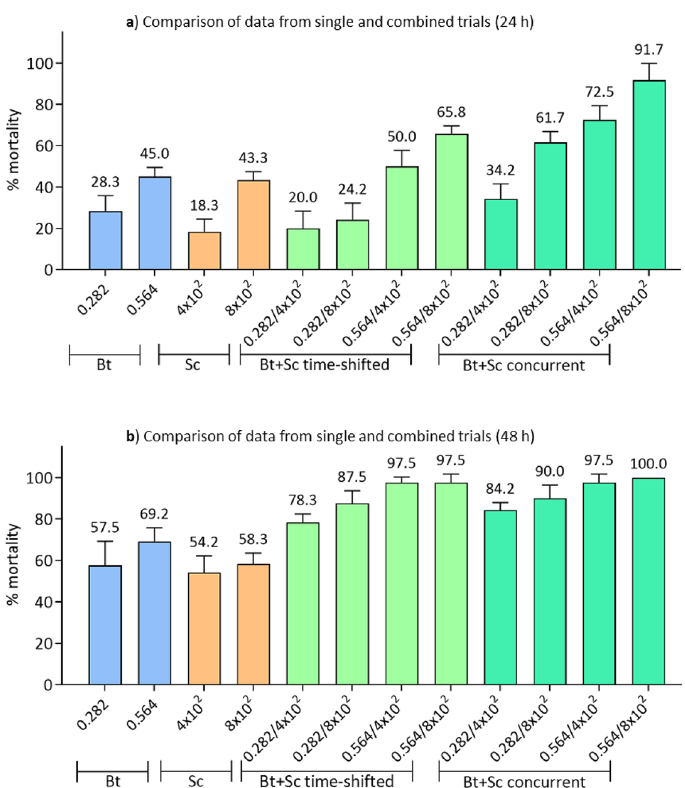
Figure 8. Cross assessment of the results obtained in single and combined administrations at 24 and 48 h. The graphs allow a direct comparison of the data obtained in the different trials showing the general improvement in the effectiveness of bio-insecticides when used in combination against D. suzukii larvae. A significant increase in mortality induced by the concurrent administration of Bt and Sc is evident. Bt concentration is expressed in μg/ mL, Sc administration is expressed as total number of